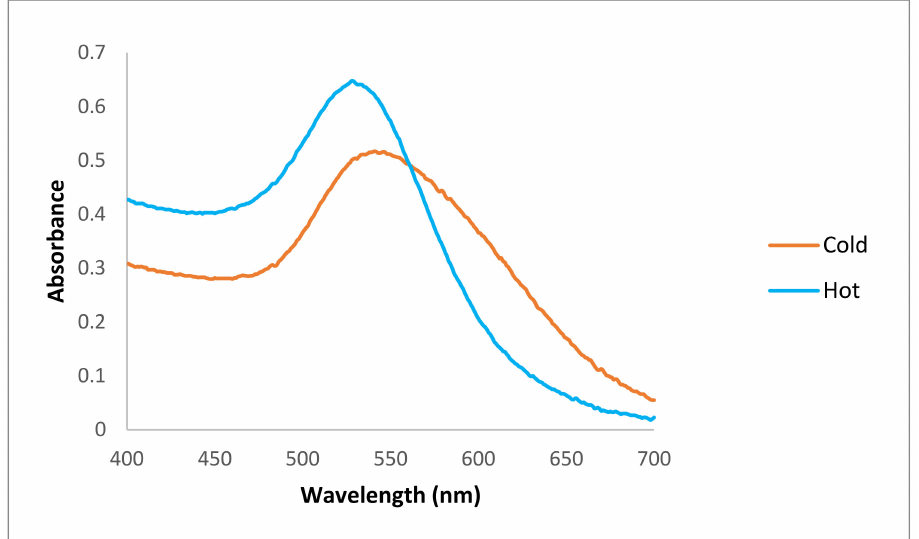
Figure 2. Spectrophotometry results of produced AuNPs. The maximum absorption peak for the “hot” AuNP dispersion was 528 nm (the blue line) and for the “cold” AuNP sample was 541 nm (the orange